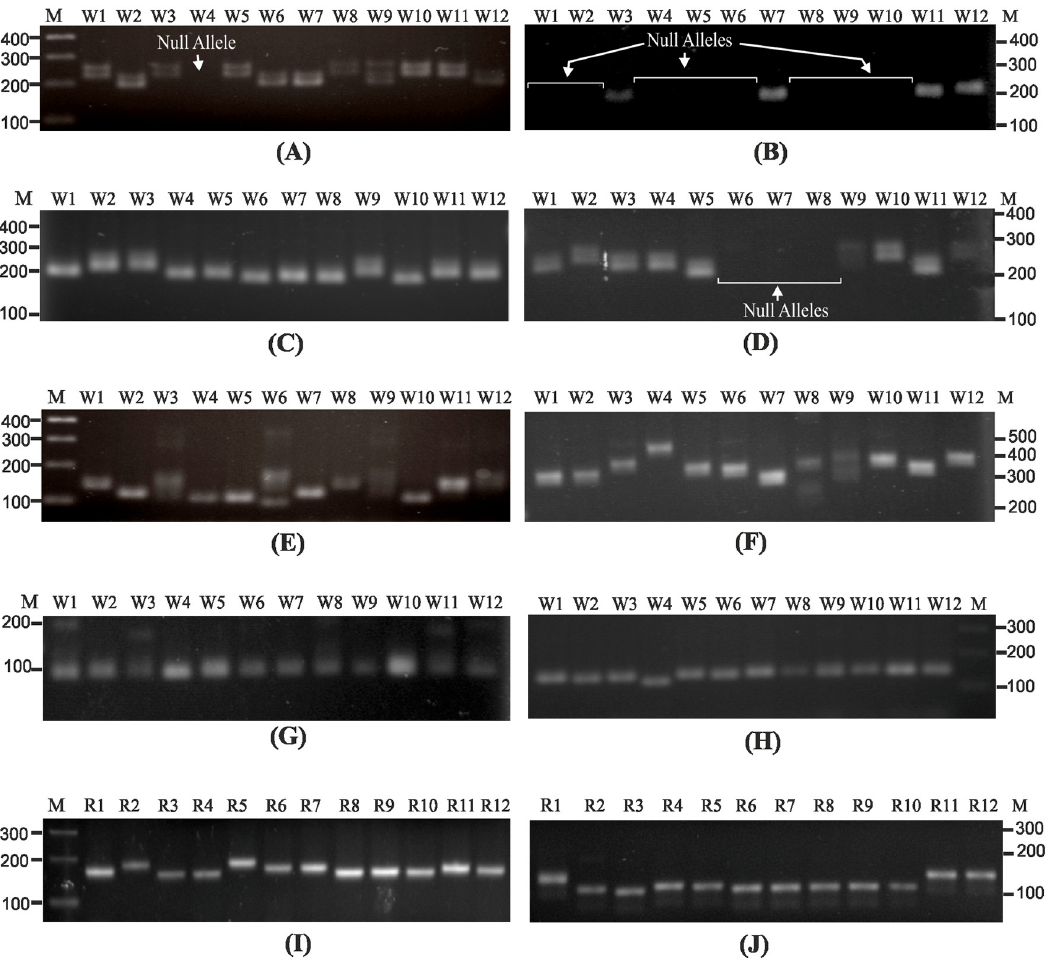
Fig 3. Analysis of allelic polymorphism of STMS marker. Allelic polymorphism of STMS markers among multiple wheat (A-H) and rice (I, J) genotypes on agarose gels: A) Xgwm 282–7A, B) Xgwm 162–3A, C) Xgwm 304–5A, D) Xgwm 169–6A, E) Xgwm